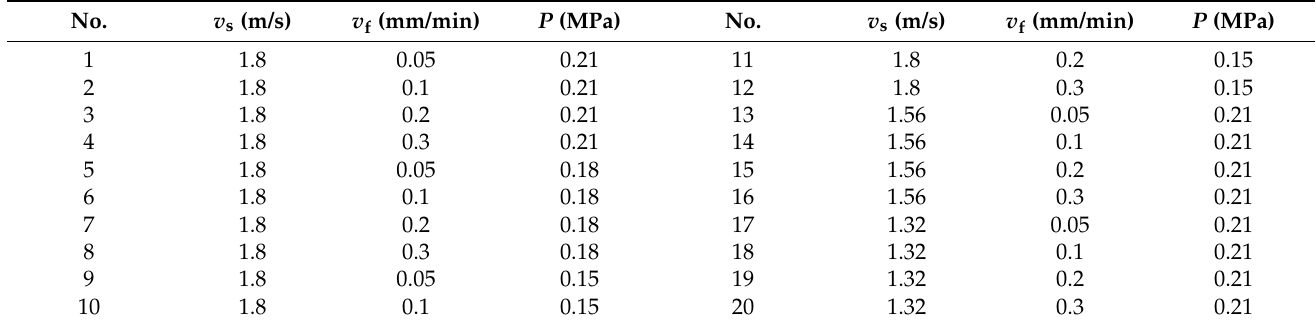
Table 5. Process parameters of sawing experiments.